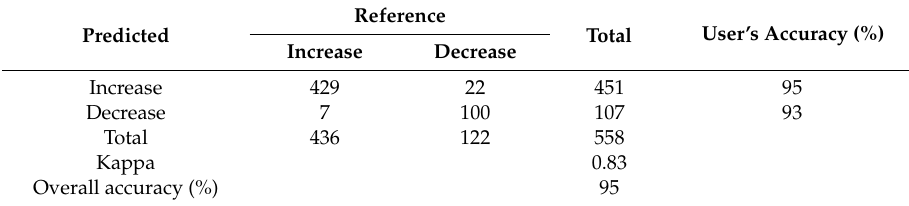
Table 6. Aggregated confusion matrix of aboveground biomass change classifications for the four districts.